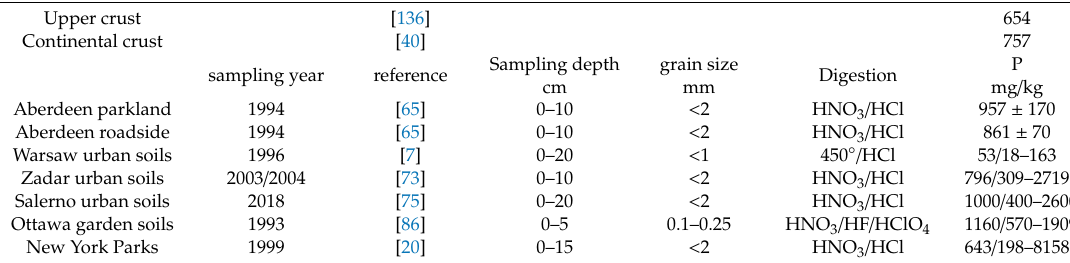
Table A3. Phosphorus in urban